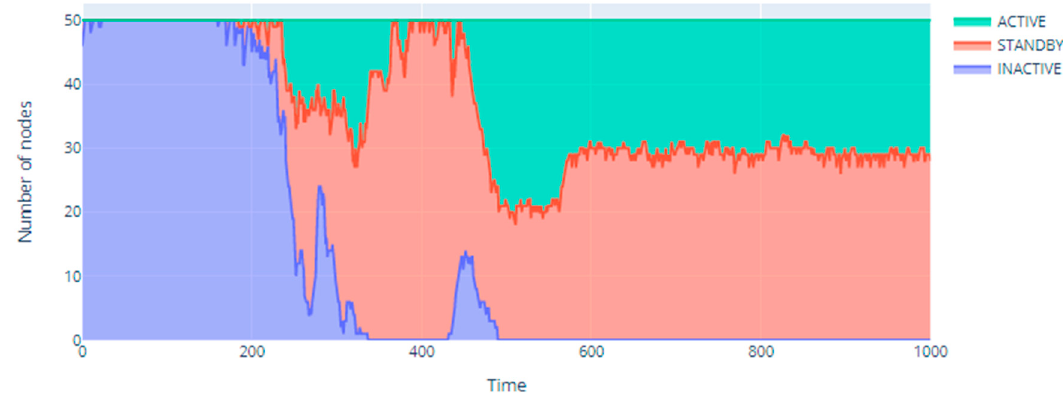
Figure 6. Distribution of node states throughout the simulation.